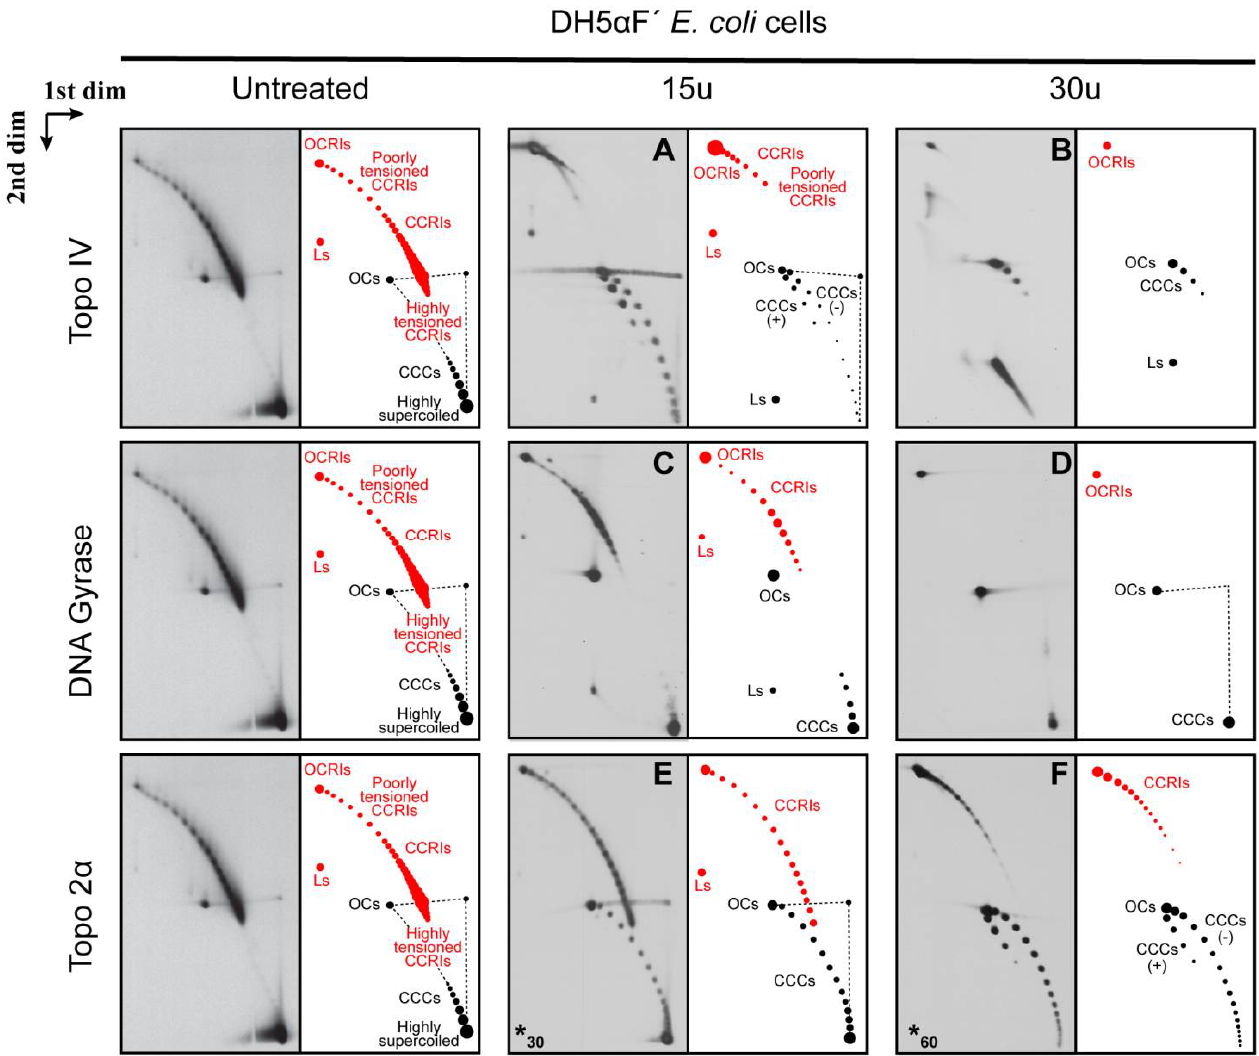
Figure 4. Immunograms and interpretative cartoons of intact untreated and treated forms of pBR- TerE@ AatII isolated from DH5 α F’ E. coli cells analyzed by two-dimensional agarose gel electrophoresis. The immunograms to the left correspond to the untreated sample and are only shown for comparison. Samples were treated with 15 units ( A , C ) or 30 units ( B , D ) of the topoisomerases in vitro, as indicated in Material and Methods, except for topo 2 α , where 30 units ( E ) and 60 units ( F ) were used (indicated by an asterisk at the left down corner). Non-replicating (+) and ( − ) CCCs and OCs are depicted in black. Dashed straight lines correspond to smears of the most abundant species that occur during the first and second electrophoresis. CCRIs and OCRIs are depicted in red. Where it applies, fully replicated catenanes—CatAs, CatBs and CatCs—are depicted in light blue, dark blue and green, respectively. The positions of highly supercoiled as well as highly and poorly tensioned CCRIs are indicated. The immunograms on top correspond to samples treated with Topo IV; below are the immunograms that correspond to samples treated with DNA gyrase and at the bottom the immunograms that correspond to samples treated with Topo 2 α as indicated in Material and Methods. * In this case a different number of units was used.